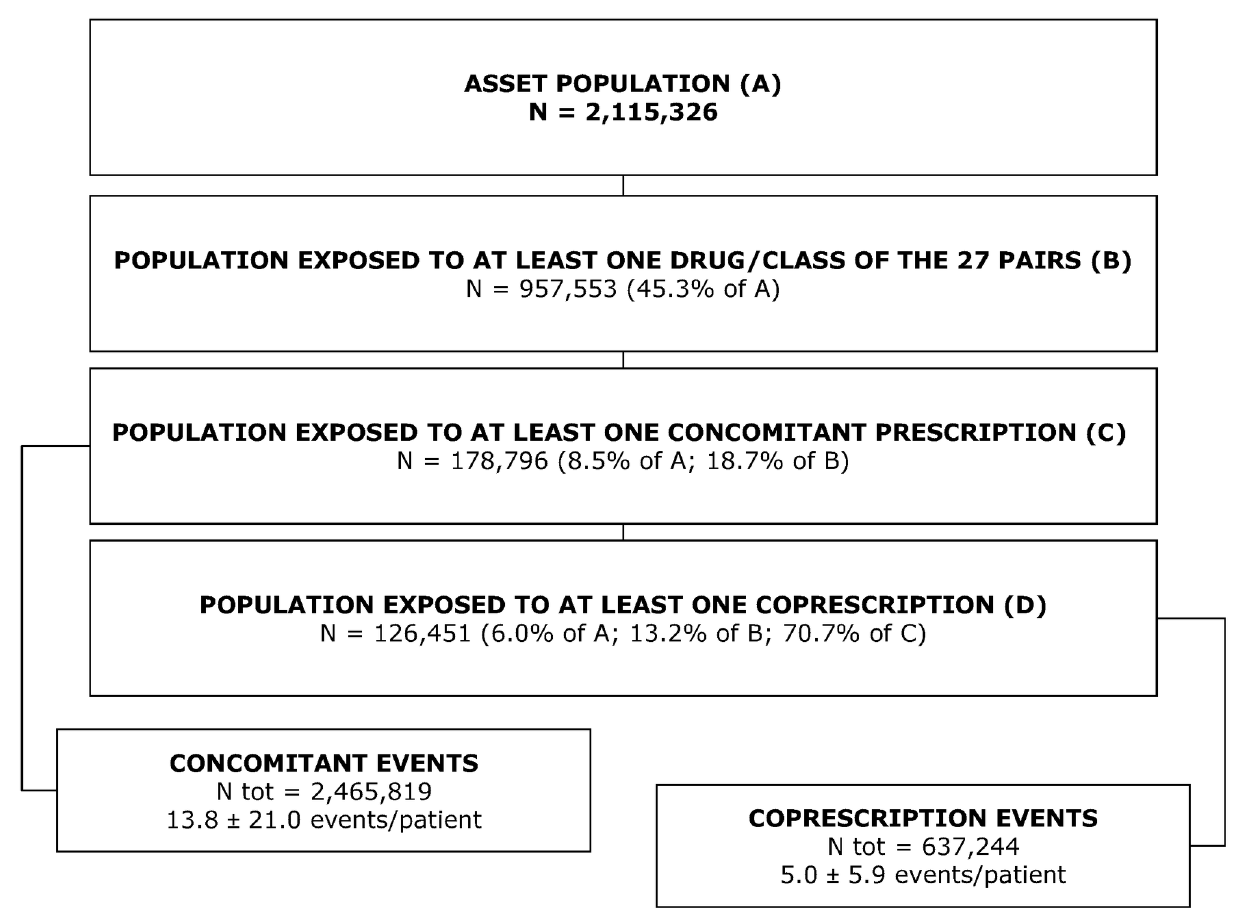
Figure 1. Number and proportion of patients involved in